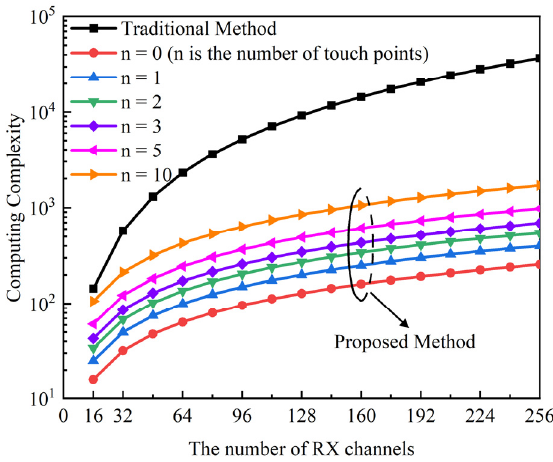
Figure 14. The computing complexity of the traditional method and the proposed method, with the different number of RX channels and the different number of touch points in a frame. different number of RX channels and the different number of touch points in a